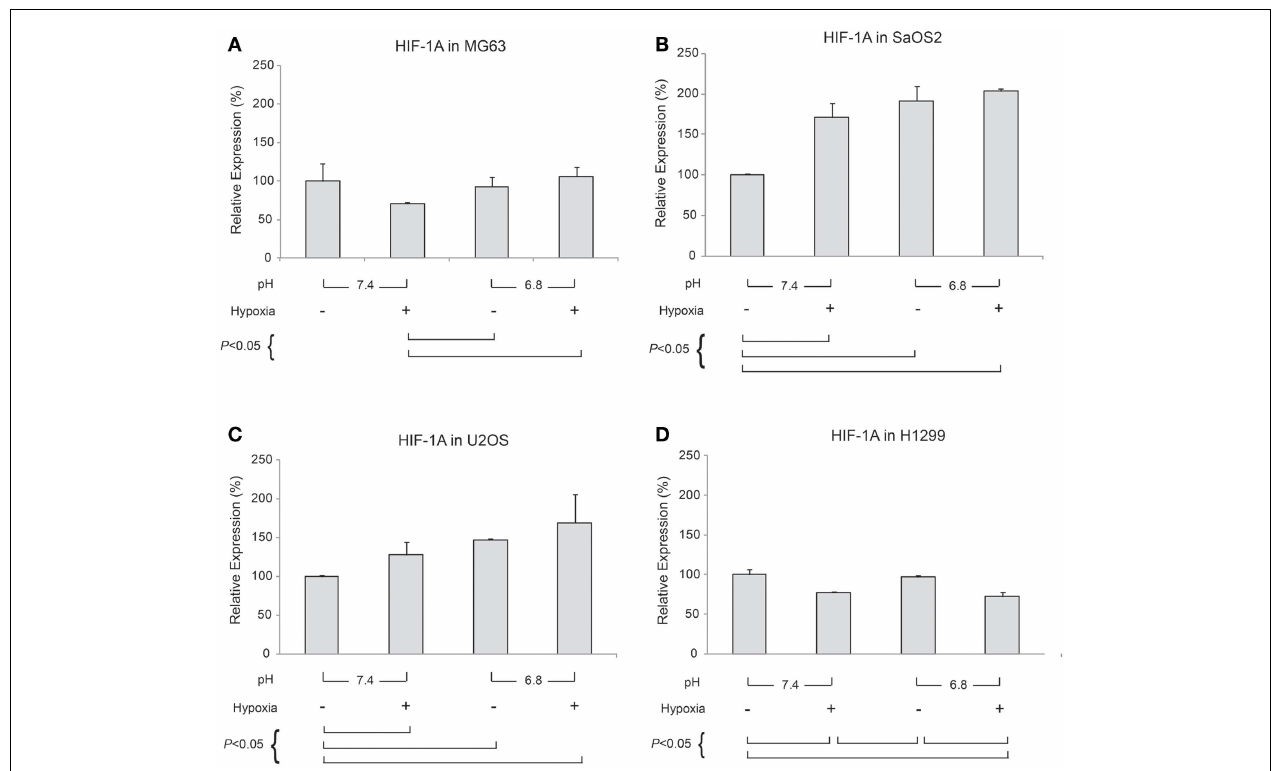
hydrostatic pressure, and indicate statistically significant differences between different combinations of pH (7.4 or 6.8) and either normoxia (20% O 2 ) or hypoxia (2% O 2